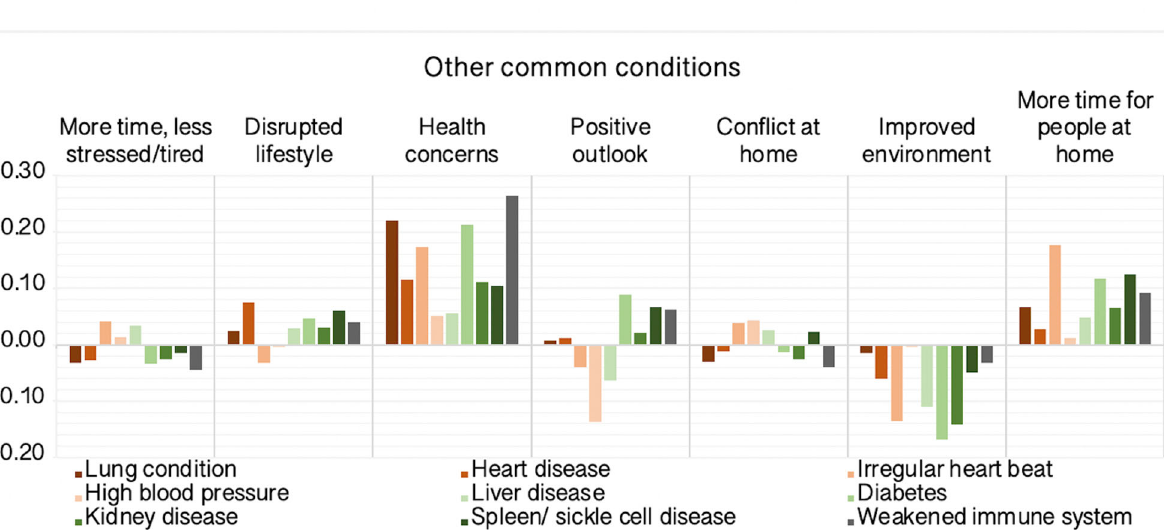
Fig. 9 Self-perceived impact of the COVID-19 pandemic by pre-existing conditions. Differences in PD-GIS component scores for people reporting psychiatric, neurologic and other pre-existing conditions relative to controls in SD units. Source data are provided as a Source data fi